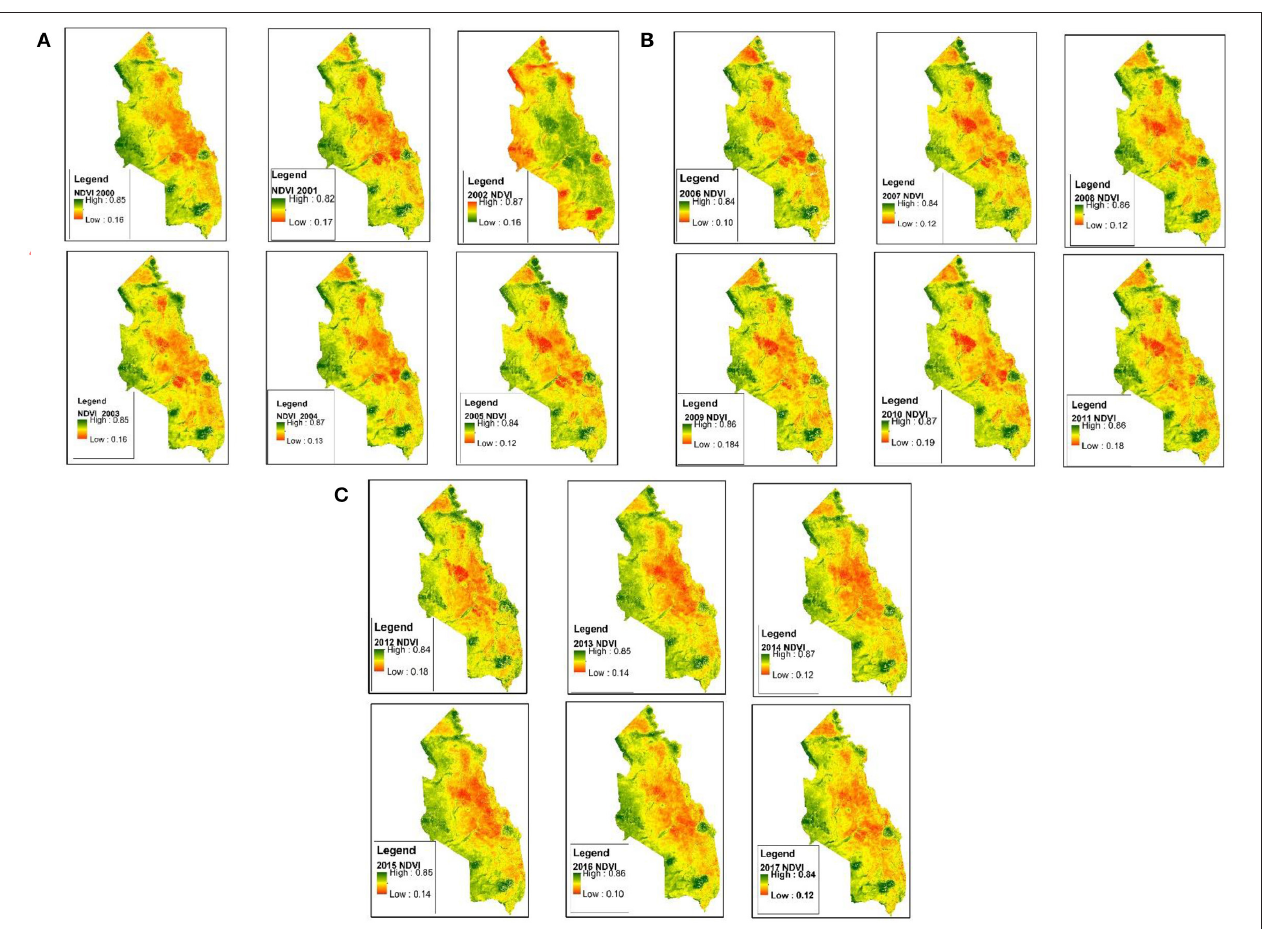
FIGURE 3 | (A–C) represent mean NDVI values for the period of 18 years between 2000 and 2017.